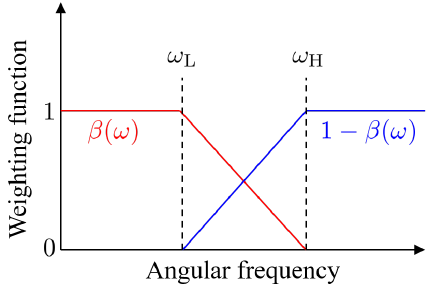
Figure 9. Weighting function β ( ω ) and 1 − β ( ω )